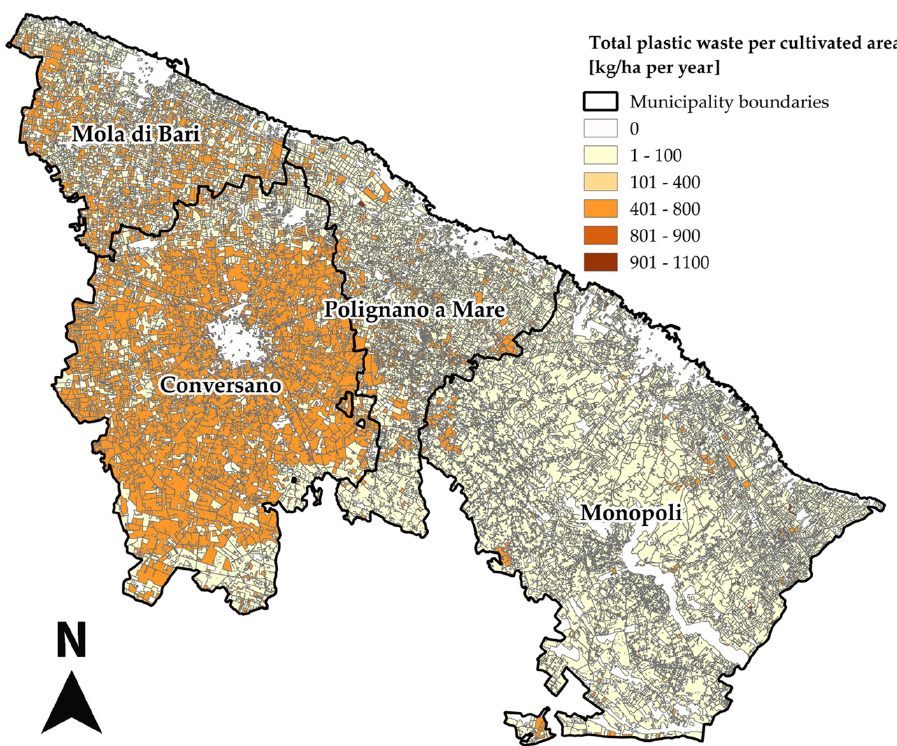
Figure 4. Distribution of the total APW in the four municipalities in the scenario of longer lifespans (1st scenario).